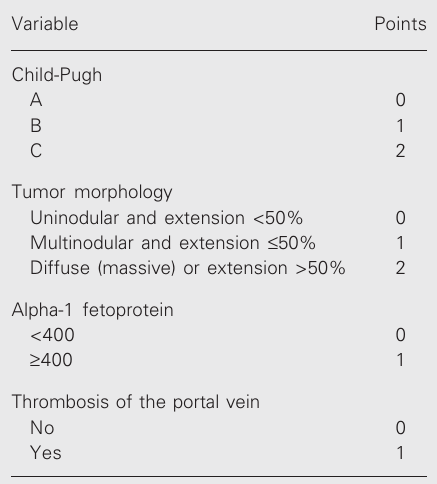
CLIP classification: 0 to 6 points.